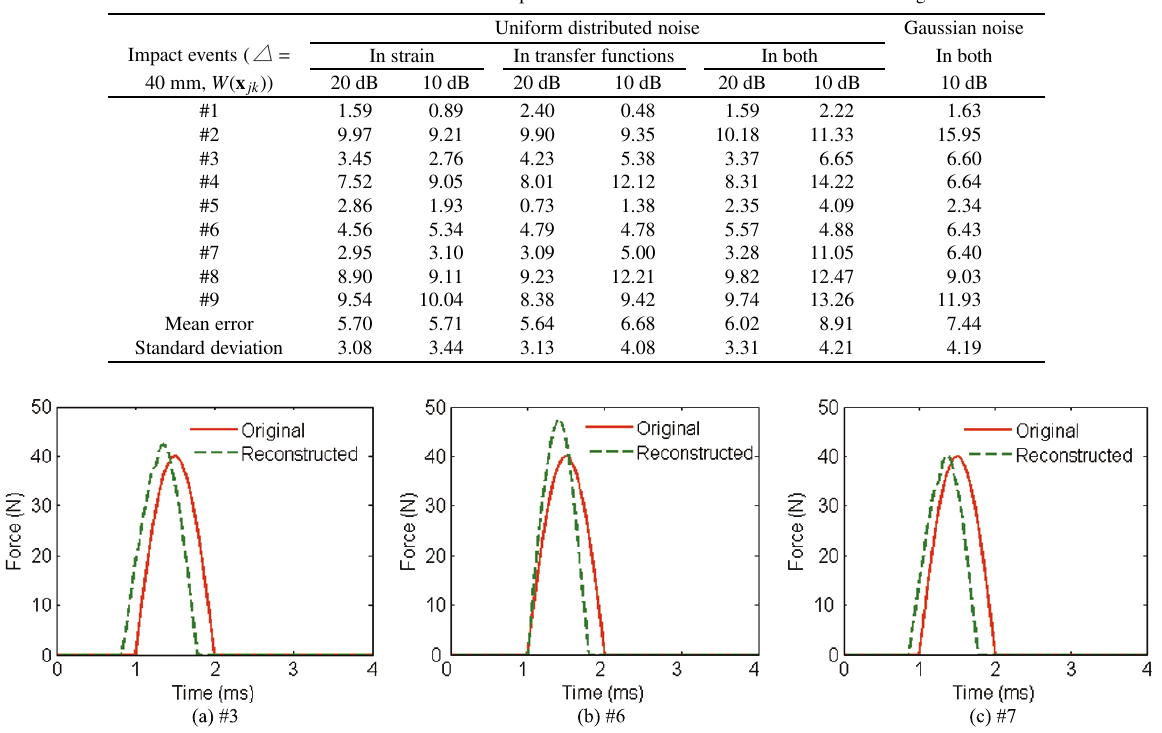
Table 2 Mean error and standard deviation in impact location detection with noises contained in signals